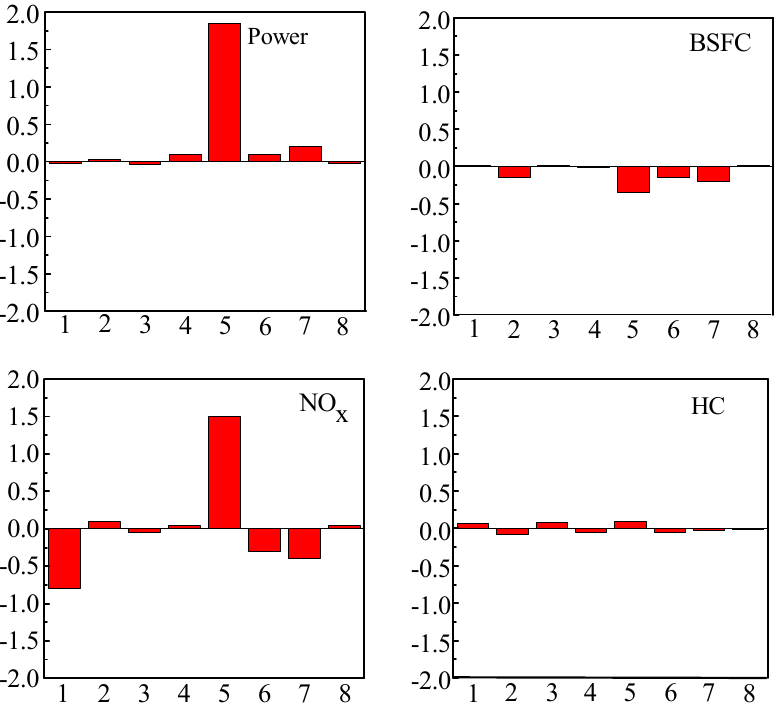
Figure 11. Comparisons of relative contribution on the engine characteristic in low speed (628 rpm) and in lean operation zone (Equivalence ratio Φ = 0.25).